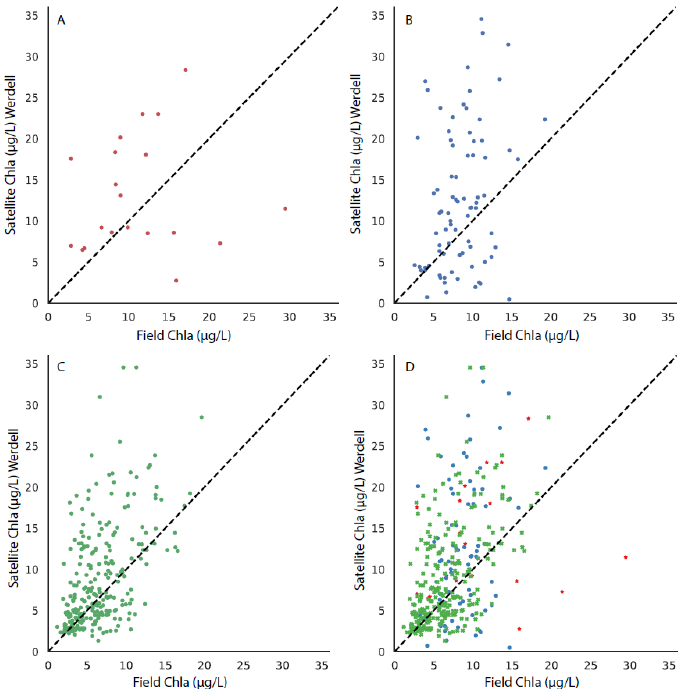
Figure 7. The matchup between the field chla and the MODIS-Werdell algorithm, with the 1:1 line shown in each subplot for stations in ( A ) the upper bay, ( B ) the middle bay, ( C ) the lower bay, and ( D ) all stations, with the upper, middle, and lower bays differentiated by symbol color and style.